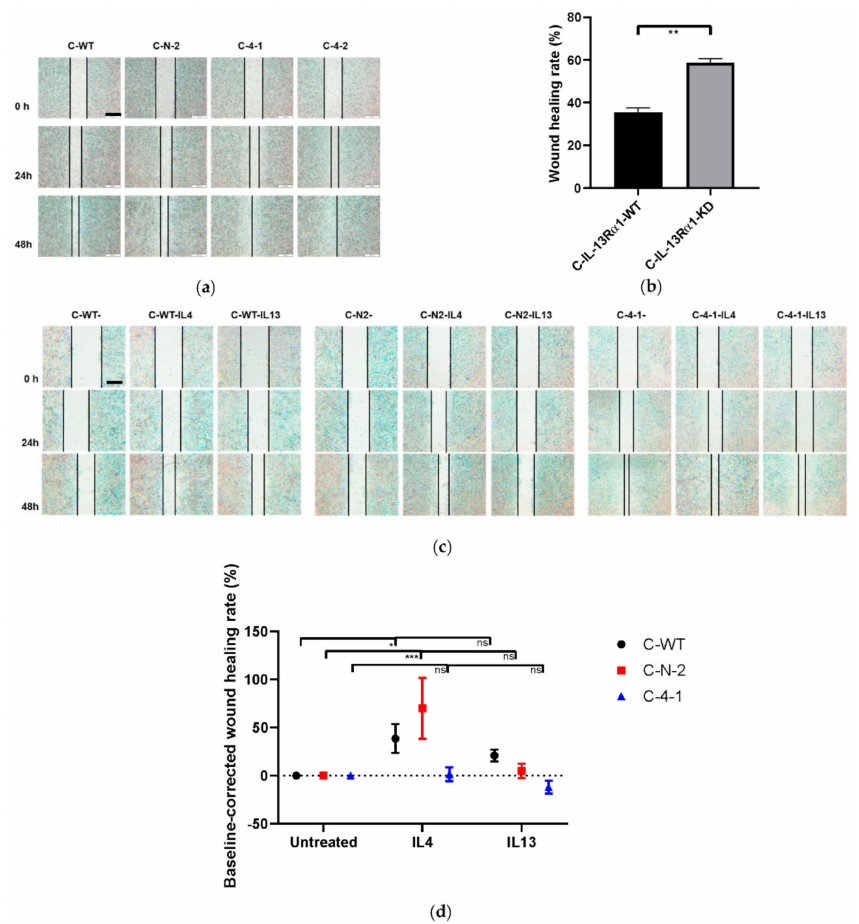
Figure 5. Cell mobility in the wound healing assay. ( a , b ) Effect of IL-13R α 1-downregulation on cell mobility. ( a ) Wound healing of C-WT, C-N-2, C-4-1 and C-4-2. Representative pictures shown were recorded at 0, 24 and 48 h after scratch. C-4-1 and C-4-2 managed wound closure at 48 h; ( b )